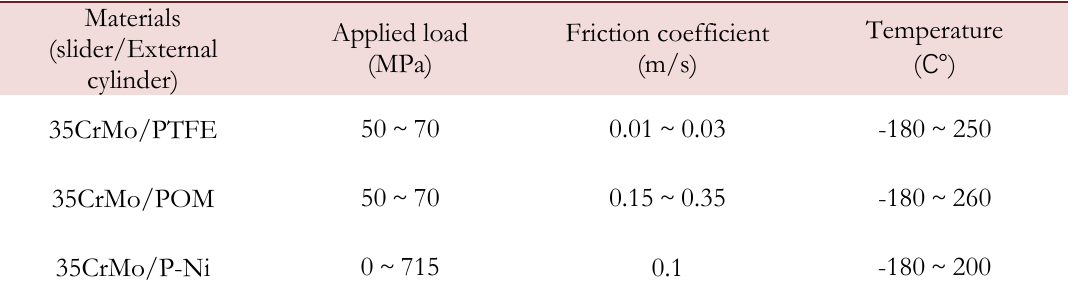
Table 1: Property of numerical models of hydraulic hammers with horizontal oriented sliders.